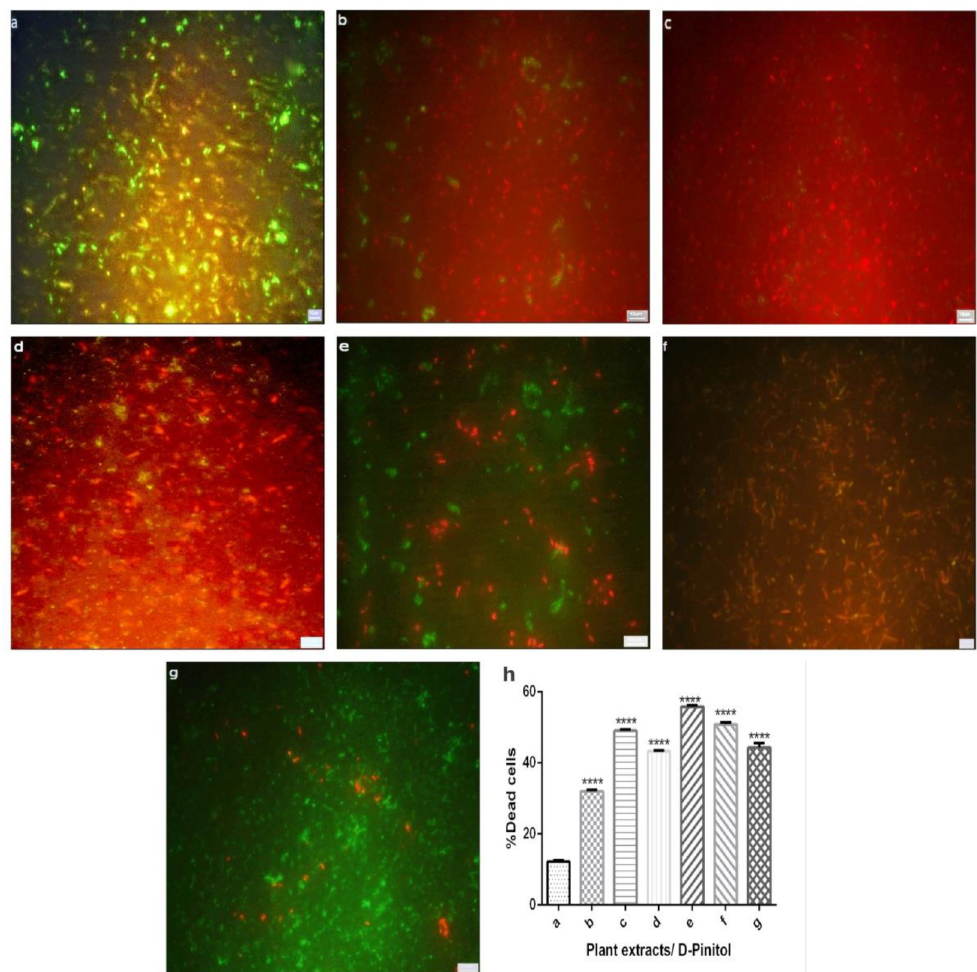
compared with the